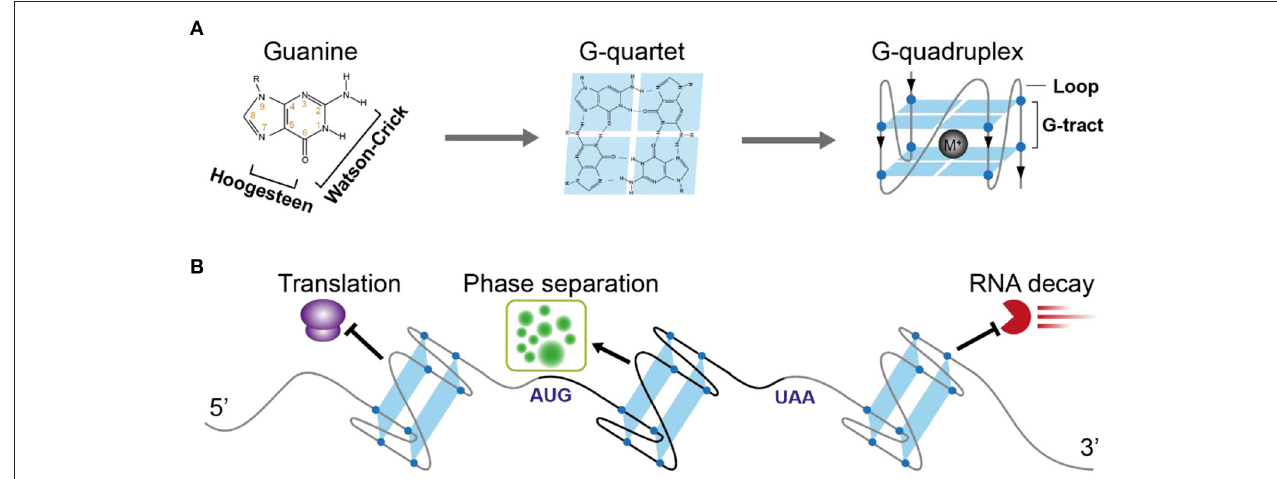
FIGURE 1 | Schematic illustration of RNA G-quadruplex structure and its molecular function in plants. (A) The schematic depicts the guanine, G-quartet, and G-quadruplex respectively. The chemical structure illustrates the hydrogen bonds of Watson-Crick face and Hoogesteen face of guanine forming G-quartet. G-quadruplex with two layers of G-quartet was further illustrated, with a monovalent cation between the G-quartets stabilizing the G-quadruplex. (B) The versatile post-transcriptional regulatory functions of RNA G-quadruplex in plants. 5’UTR-located RNA G-quadruplex ( ATR , SMXL4/5 , HIRD11 ) represses translation, CDS-located RNA G-quadruplex ( SHR ) triggers phase separation, 3’UTR-located RNA G-quadruplex ( CORG1 ) represses mRNA